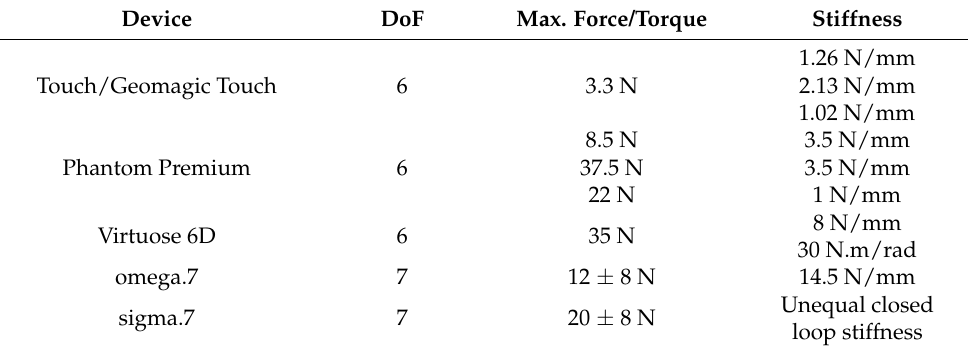
Table 2. Haptic devices with their